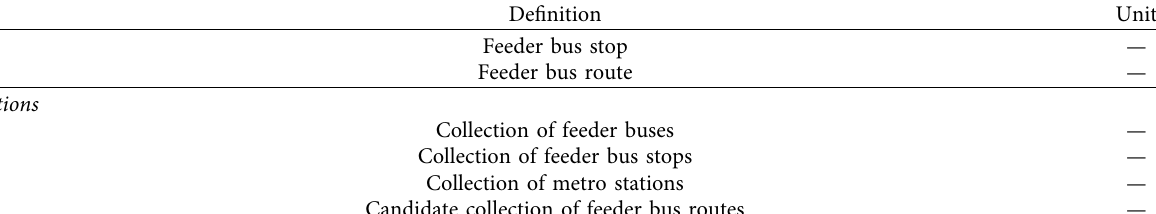
Table 1: Parameters and variables in the